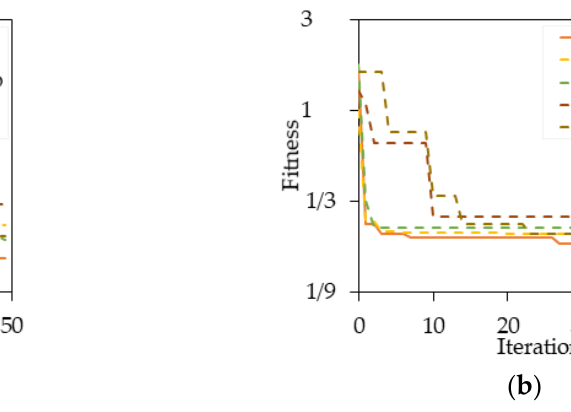
( b ) Figure 13. Evaluation metrics for each model. The results correspond to the testing period. ( a ) Di- rection along the river, ( b ) Vertical direction. The comparison analysis demonstrates that the proposed estimation model combin- ing deformation data performs better in dealing with the stress estimation under sensor failure and data loss scenarios, and especially in dealing with dam responses under unex- perienced conditions. 5.2. Evaluation of Tuning Algorithms SIE – APSO In this section, we analyze the performance of the SIE – APSO proposed in this paper via other algorithms for algorithm verification. The SIE – APSO is compared to the stand- ard PSO [32], linear descent inertia weight strategy PSO (LDIW – PSO) [33], the standard grey wolf optimizer (GWO) [34] as SI (swarm intelligence)-based technique, and the grav- itational search algorithm (GSA) [35] as a physics-based algorithm. Note that all algo- rithms were run on Intel (R) Core (TM) i5-8400 with 16 G memory, and the software en- vironment is python 3.7. The population number of each algorithm was set to 20; the max- imum number of iterations was 50; and the maximum particle velocity was set to 10% of the search domain. The convergence curve of each tuning algorithm is reported in Figure